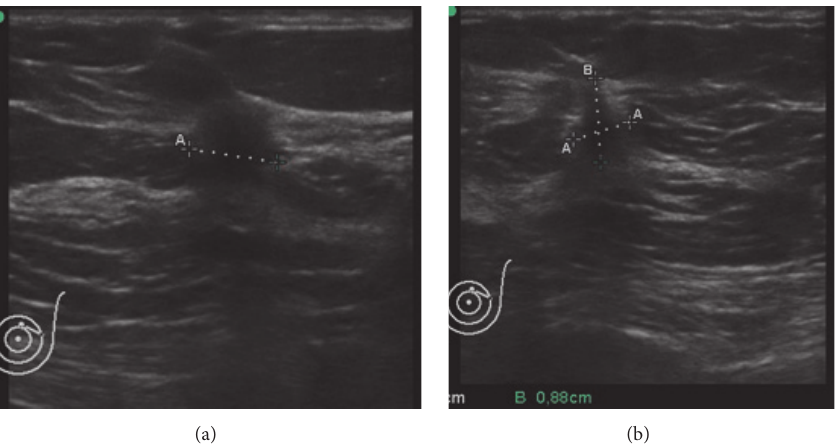
Figure 3: Ultrasound, transverse (a) and longitudinal (b) sections. A 10mm solid nodule was shown, with irregular and ill-defined margins, taller rather than wider shaped, with a hyperechoic rim and posterior acoustic shadowing: Rocha A, Servicio de Radiologia, Hospital Povisa, Vigo, Spain.